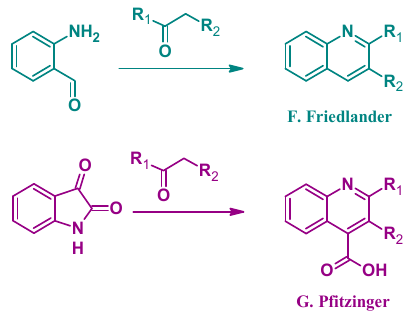
Figure 3. Quinoline synthesis methods: Friedländer reaction ( F ); and Pfitzinger reaction ( G ).